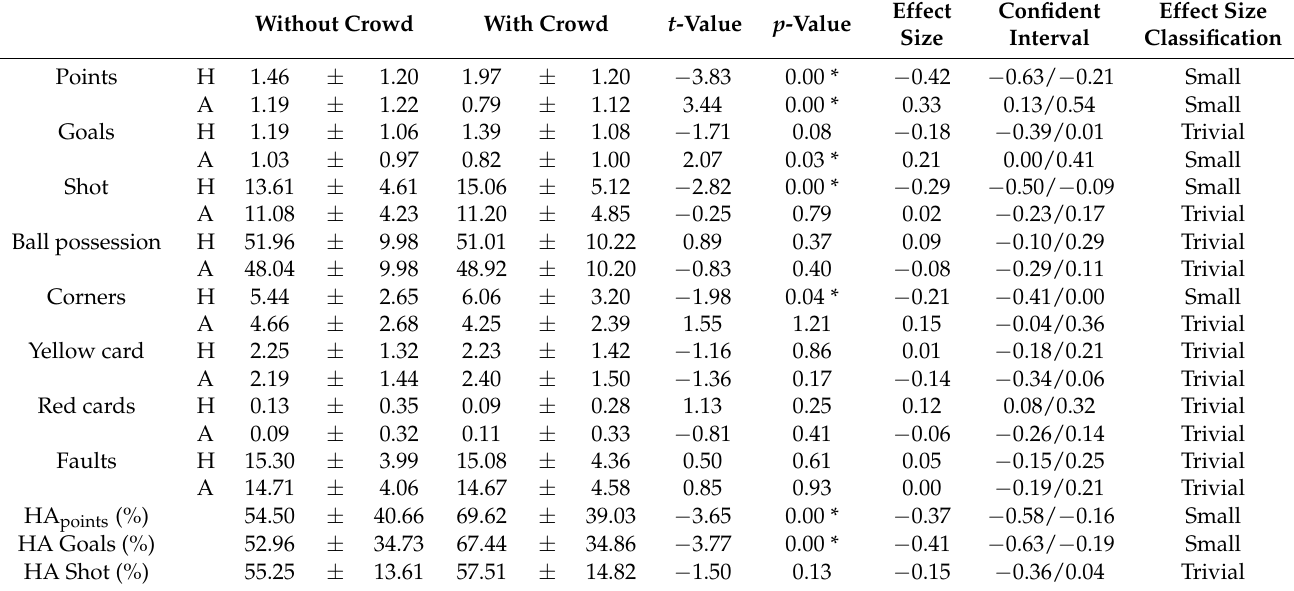
Table 3. Statistical and descriptive data for the 2021 season are divided into parts with and without crowds in the Brazilian Serie A